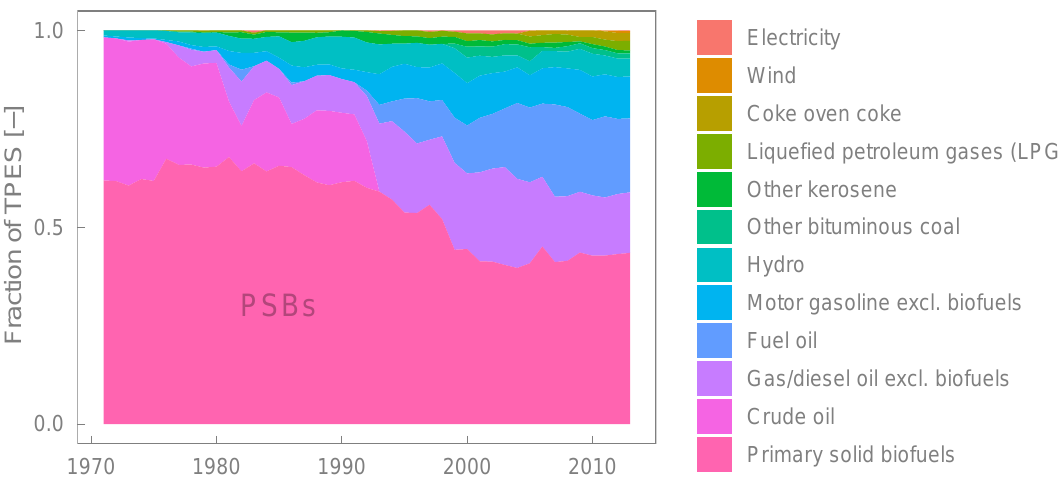
Figure 2. Sources of primary energy for Honduras from 1971 to 2013 [17]. (Electricity is considered to be a primary energy source due to net imports on the interconnected Central American electricity